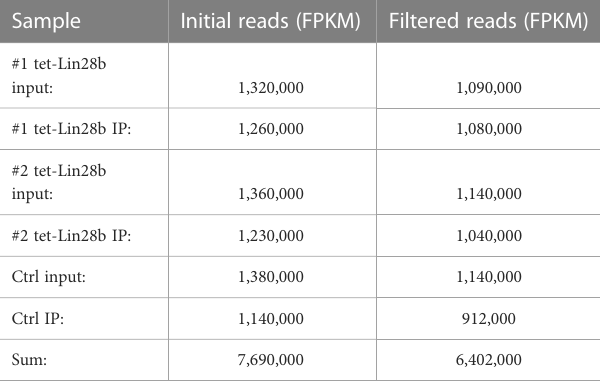
TABLE 1 RIP-seq sample FPKM values.